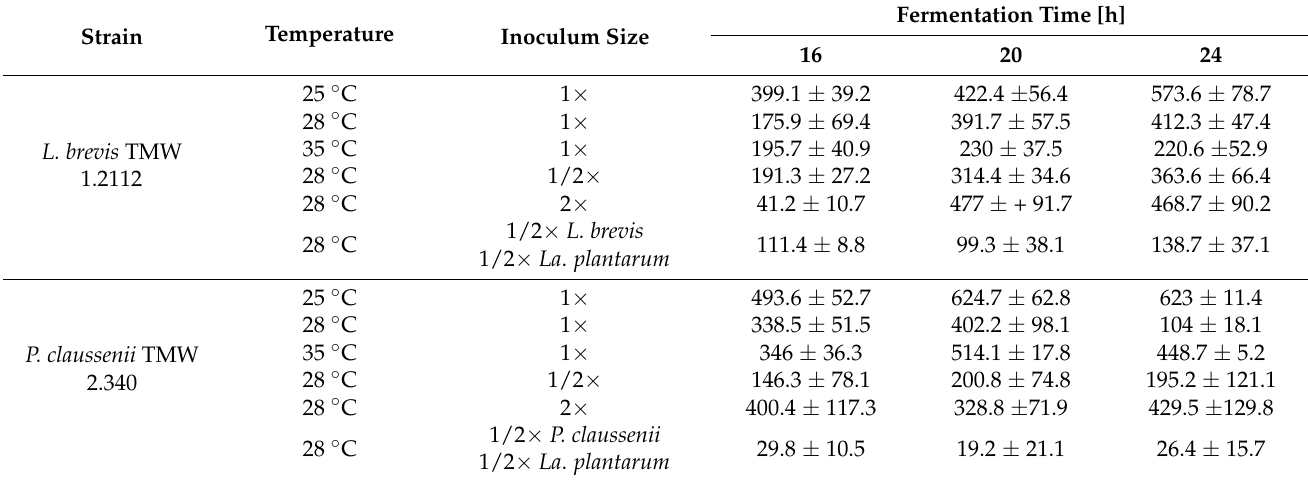
Table 2. β -glucan [mg/kg] production by varying parameters in rye fermentation by L. brevis TMW 1.2112 and P. claussenii TMW